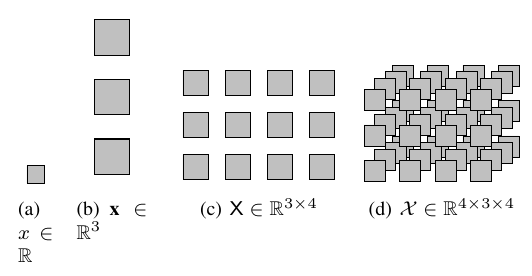
Figure 1. Scalar( x ), Vector( x ), Matrix( X ) and Tensor( X )